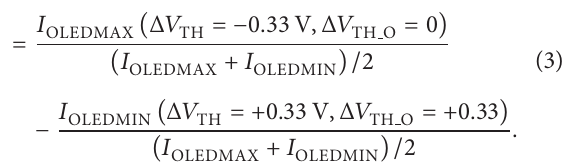
Figure 7: The nonuniformity of 𝐼 worst case ( Δ𝑉 nonuniformity is